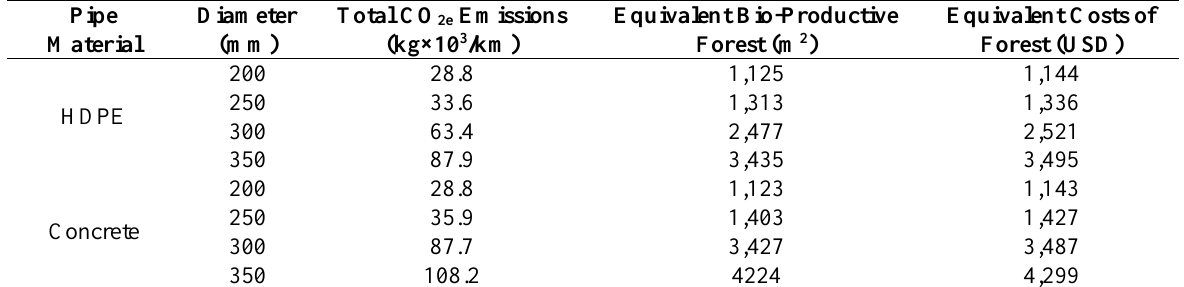
Table 4. The equivalent bio-productive area and its expenses related to each pipe segment Pipe Material